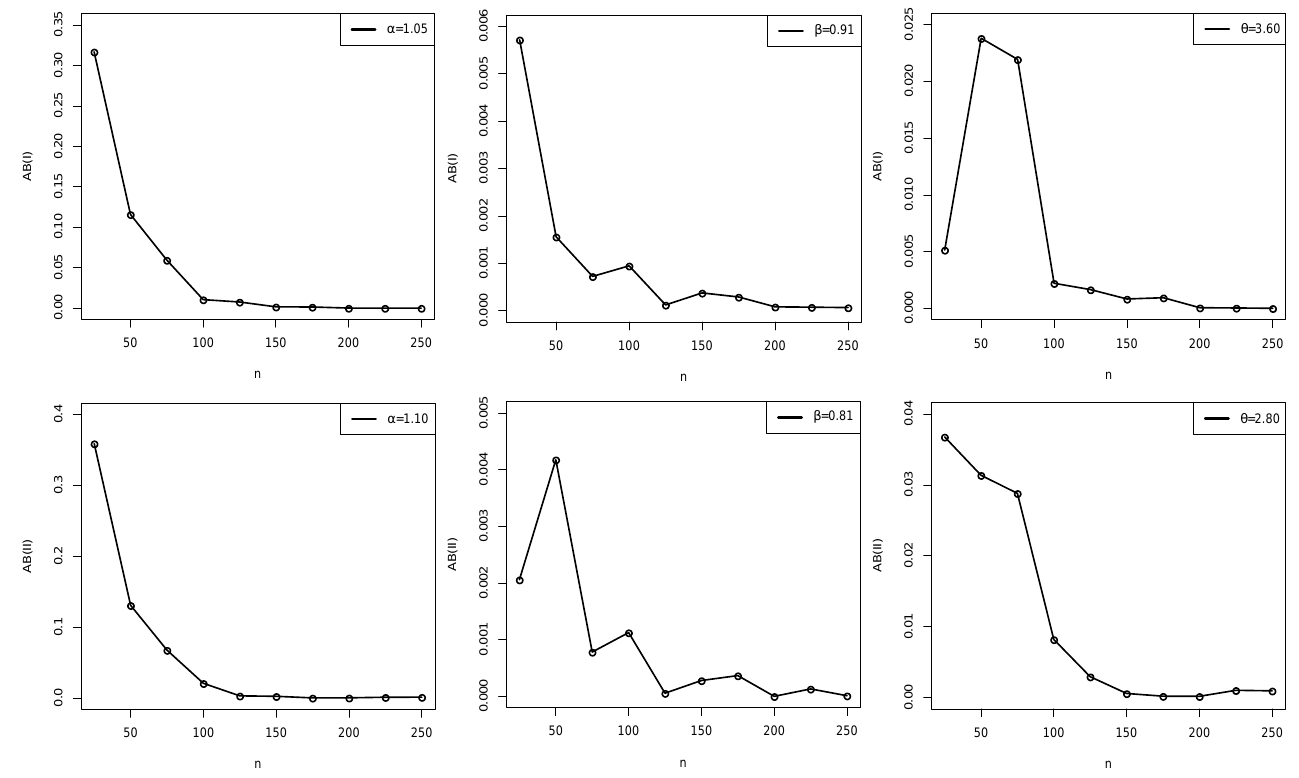
Figure 4. Plots of ABs based on the simulation of the EPAIG-ED for sets I and II.